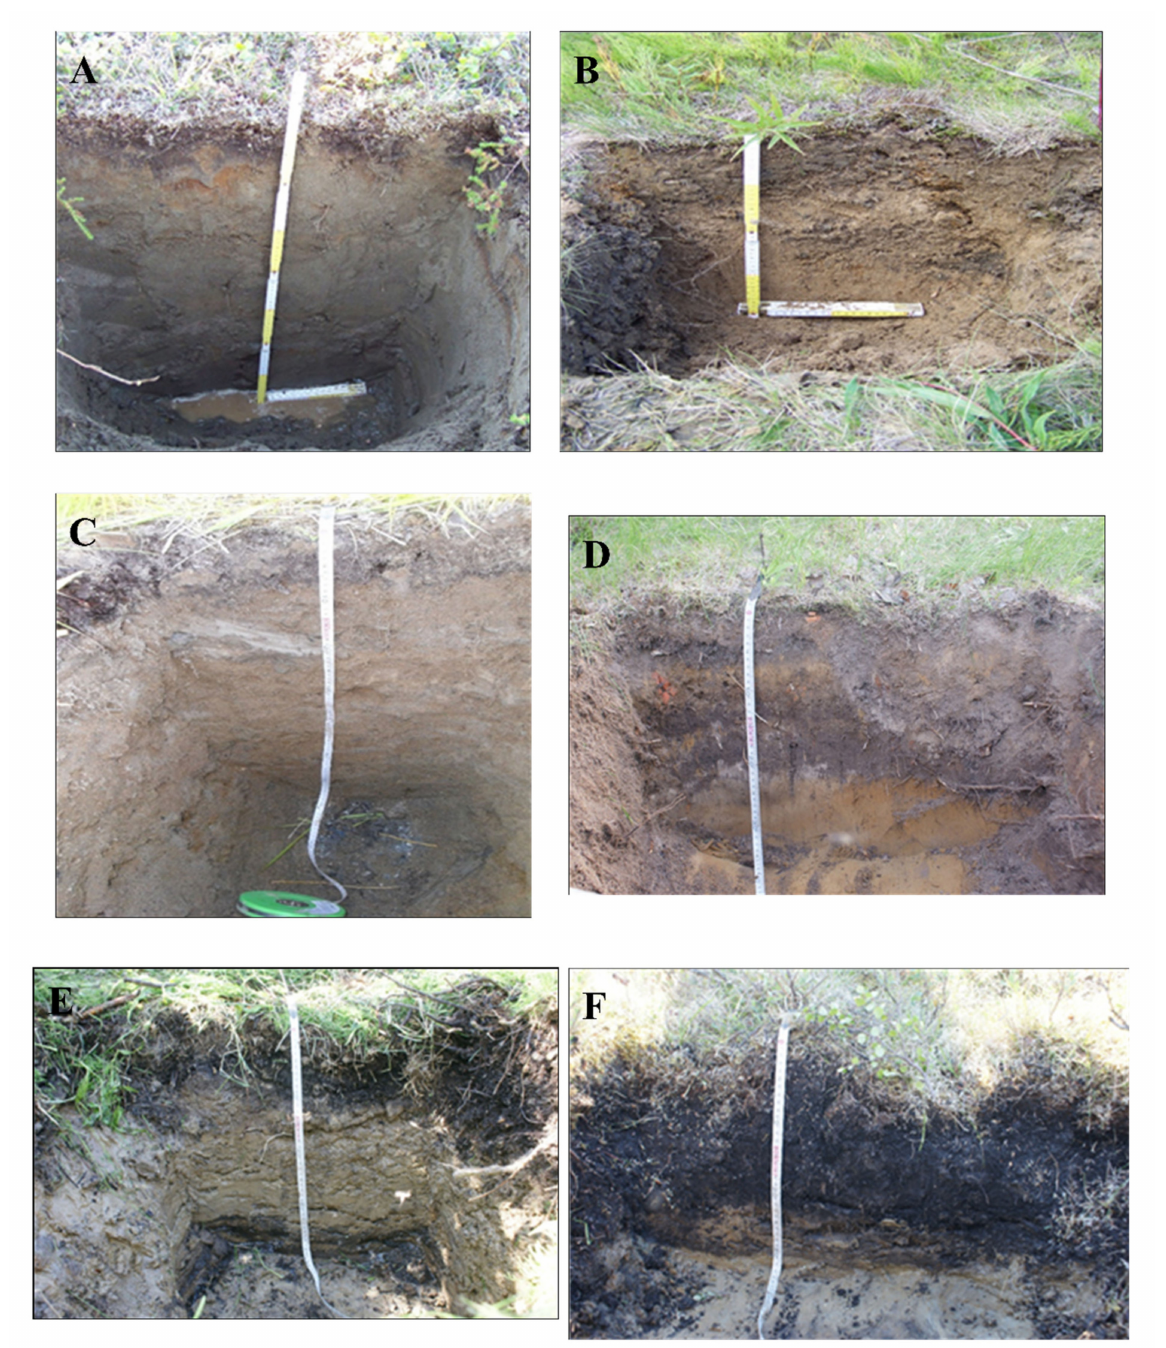
Figure 2. Soil diversity: ( A , E , F )—mature soils; ( B – D )—anthropogenically loaded